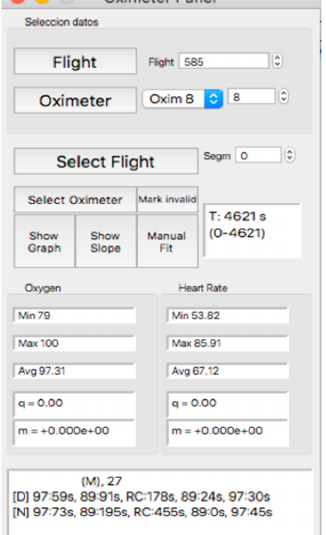
Figure 8. Visual aspect of the subpanel “Oximeter Panel”.